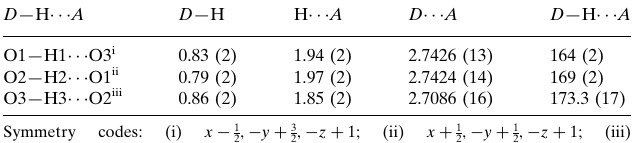
Hydrogen-bond geometry (A˚ , (cid:4)